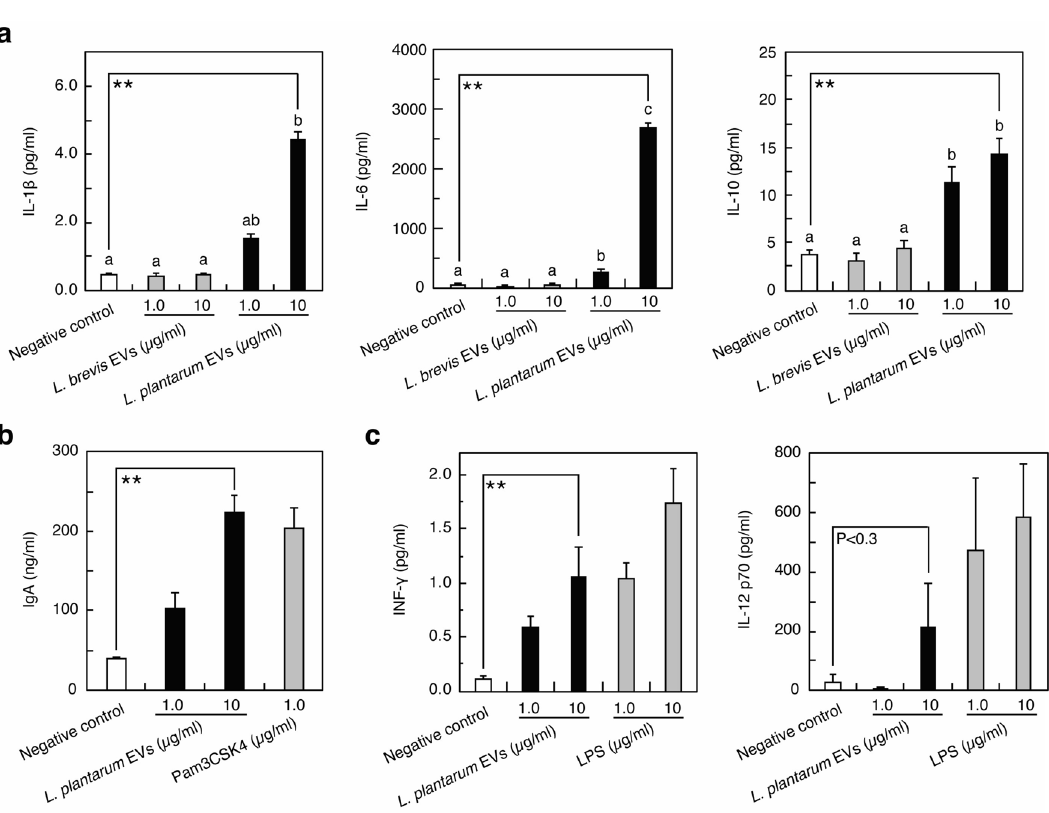
Figure 5. Stimulation of immune cells by L . plantarum EVs. The production of cytokines from Raw264 cells ( a,c ) and IgA from PP cells ( b ) was indicated. Pam3CSK4 ( b ) and LPS ( c ) were used as positive controls. PBS ( a–c ) was used as the negative control. Means ± SD, n = 3. ( a ) Bars identified by the same letters are not significantly different from each other (P > 0.01) by the Tukey’s test. ( a–c ) the Dunnett’s test, **P < 0.01 compared with negative